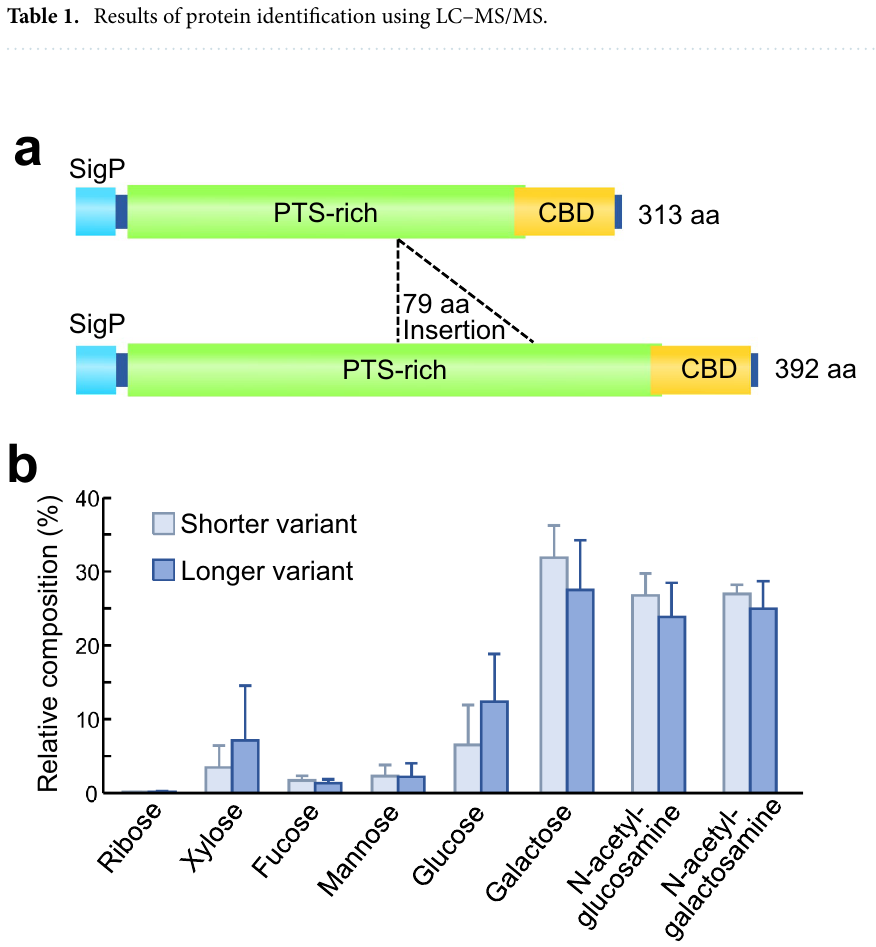
Figure 2. Swollen crypt-specific mucin-like glycoprotein designated as SC mucin. ( a ) Schematic structure of shorter variant and longer variant of the SC mucin proteins. The bars represent signal peptide domains (SigP), proline, threonine and serine-rich domains (PTS-rich), and chitin-binding domains (CBD). ( b) Composition of monosaccharides liberated by acid hydrolysis of shorter variant and longer variant of the SC mucin proteins retrieved from SDS-PAGE gels ( N =